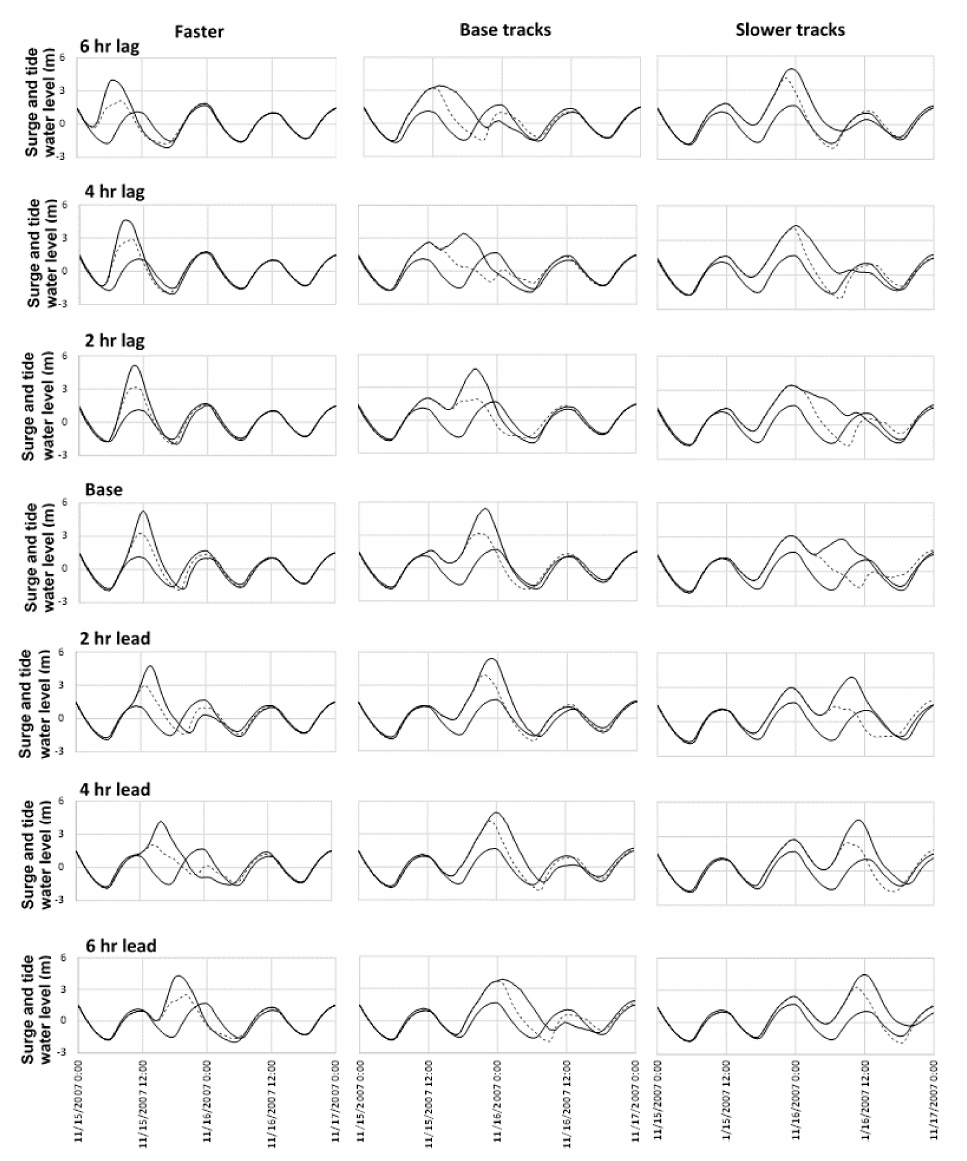
Figure 9. Comparison among surge profiles for “faster” ( left ), “base” ( center ) and “slower” ( right ) cases at Sitakunda at different tidal phases at 2 h intervals when wind is artificially removed after landfall; thick continuous lines: tide only runs, thin continuous lines: surge–tide interaction runs and dotted lines: surge–tide interaction runs when wind is